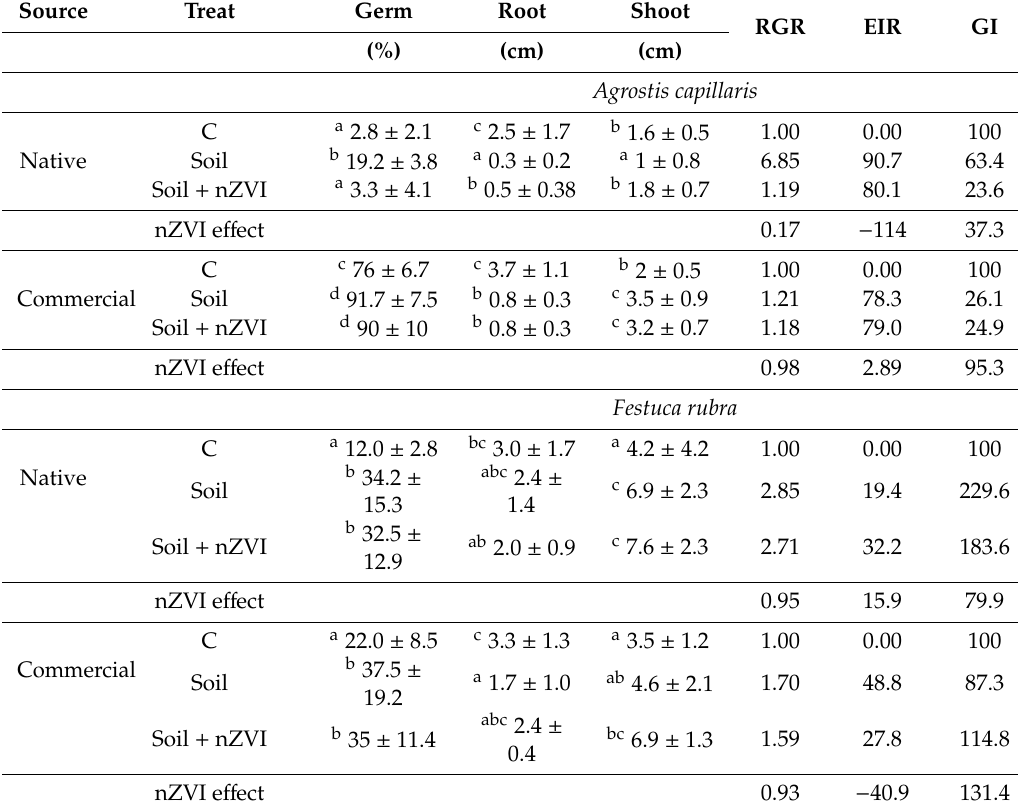
Table 2. Mean values ± standard deviation of the seedling characteristics after the germination experiment. Total germination (%), root and shoot length (cm), relative germination rate (RGR), elongation inhibition rate (EIR) and germination Index (GI). Treatments: control (C), contaminated soil, and contaminated soil + 1% nZVI (nZVI). The calculations of RGR, EIR and GI are provided for both control contaminated soil and control without soil and denoted as “Soil + nZVI” and “nZVI e ff ect”, respectively. Source of seeds: native from contaminated site and commercial. Di ff erent letters represent significant di ff erences under Tukey’s honest significance test for p <